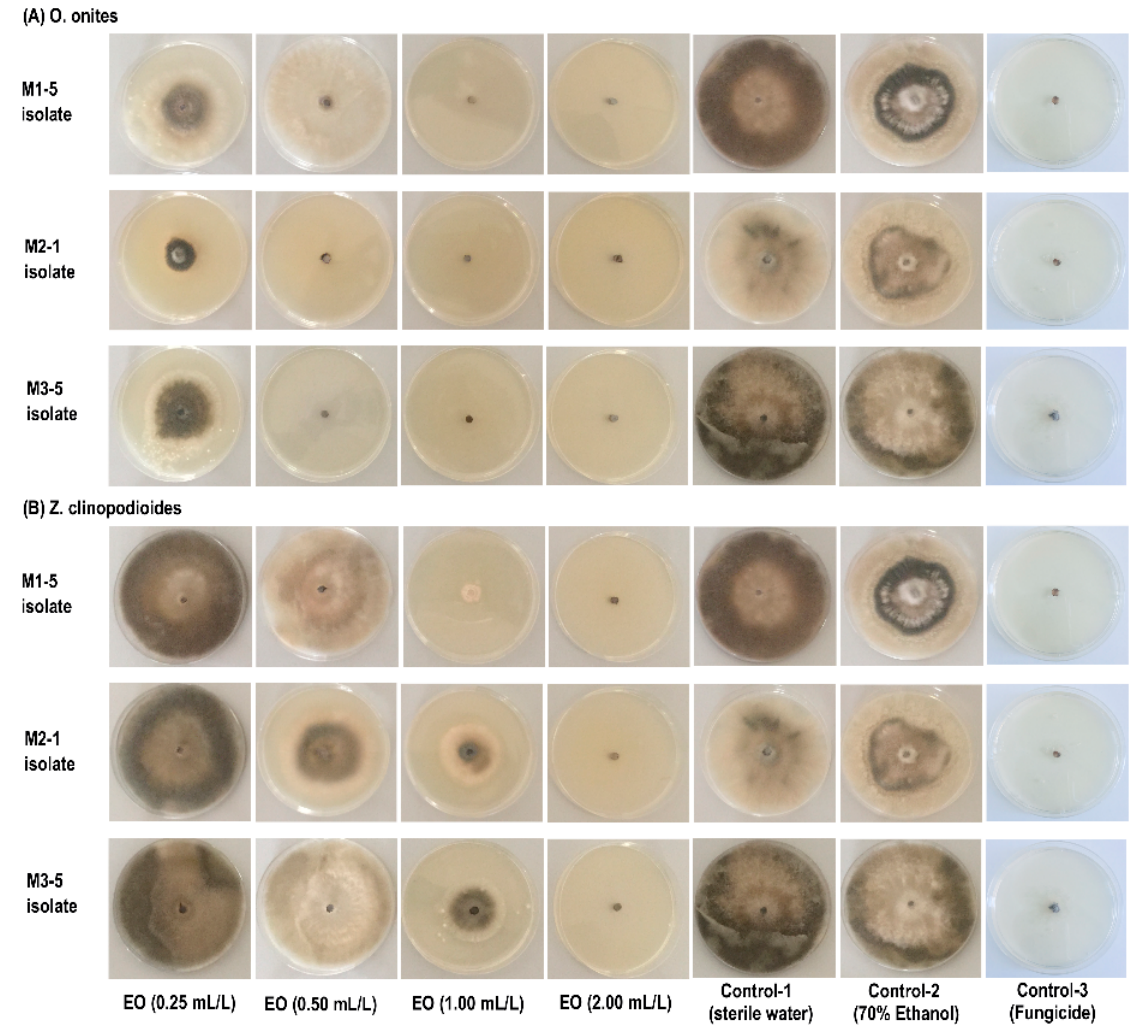
Figure 1. Effect of different application doses of ( A ) O. onites and ( B ) Z. clinopodioides essential oils, added to the PDA media, on the mycelial growth of B. cinerea isolates (M1-5, M2-1 and M3-5) after 7 days of incubation.